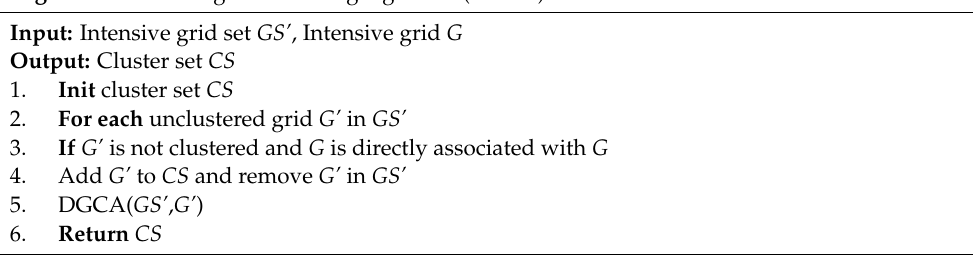
Algorithm 2. Dense grid clustering algorithm(DGCA)